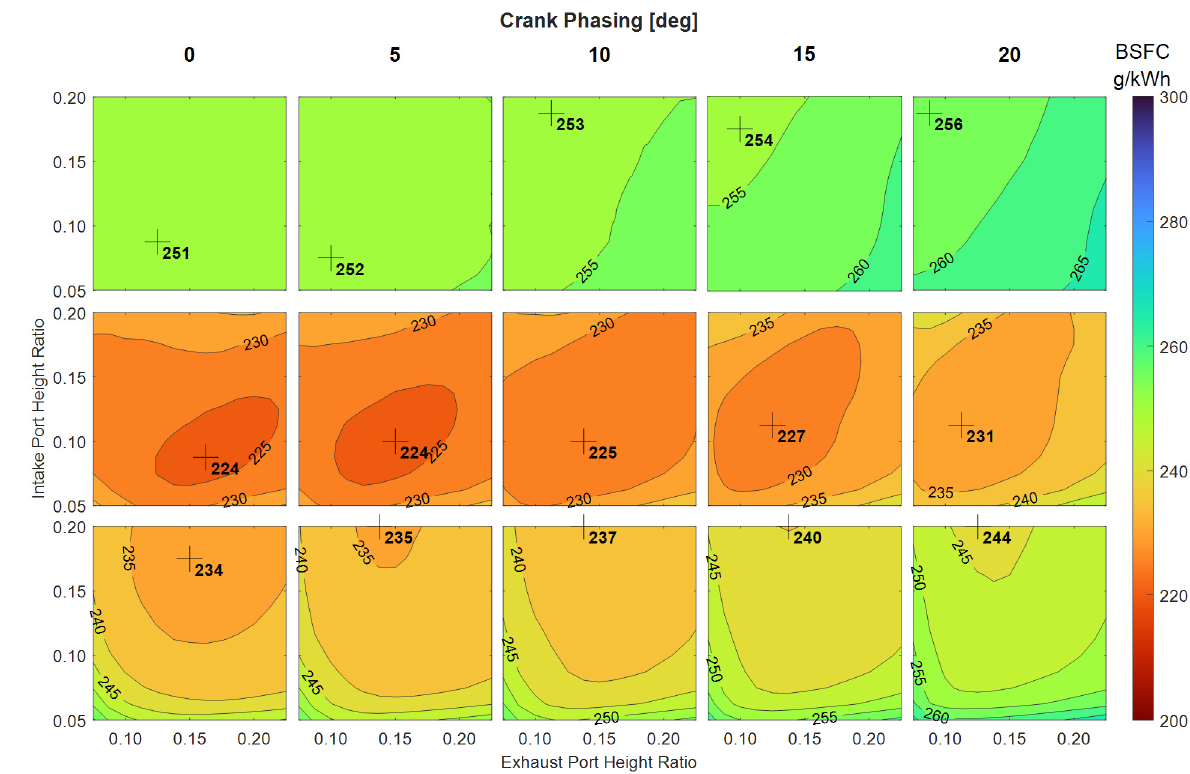
Figure 10. Variation of BSFC with crankshaft phasing and intake and exhaust port height-to-stroke ratio at operating points ( A ), ( B ), and ( C ) (1500 min − 1 , 3-bar BMEP; 1500 min − 1 , 12-bar BMEP; and 3000 min − 1 , 10-bar BMEP, respectively); λ = 1.